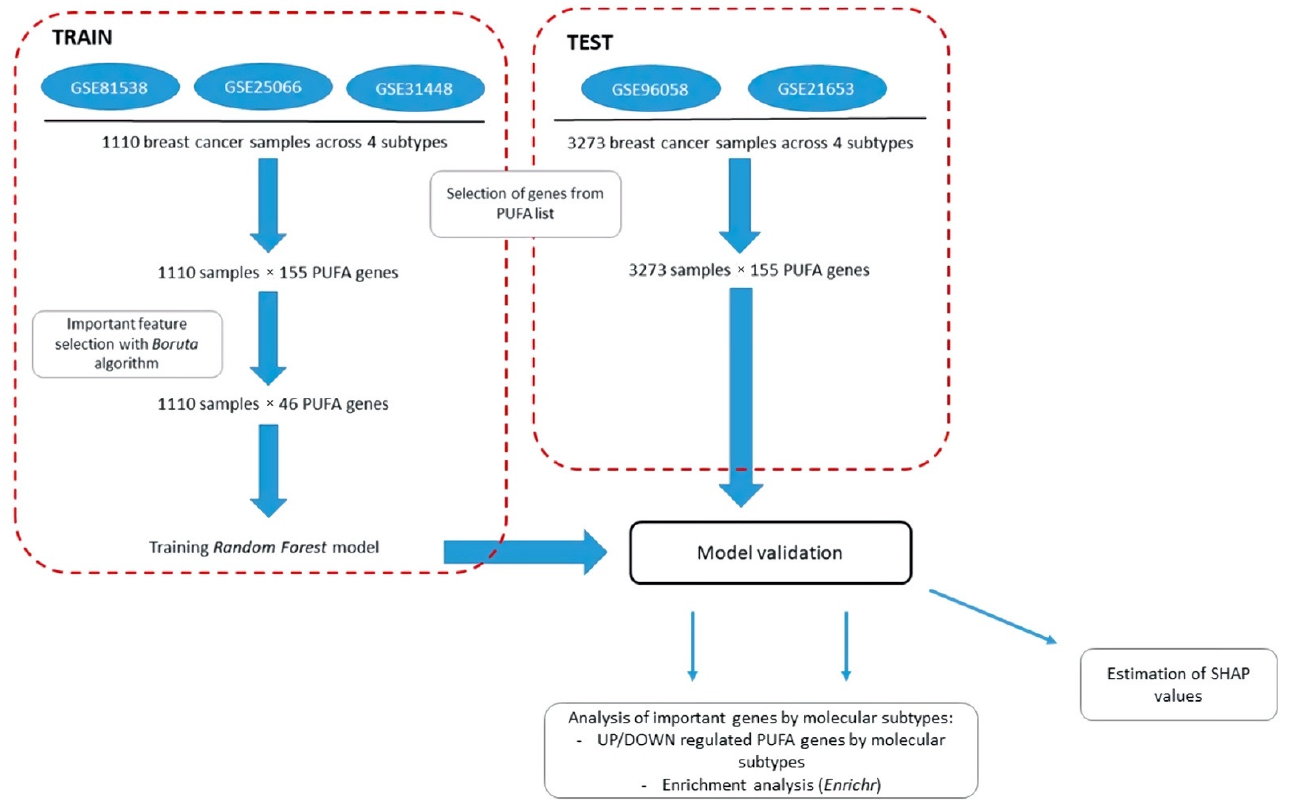
Figure 4. Workflow for studying differences in PUFA metabolism across four molecular subtypes of breast cancer. Processed expression matrixes for GSE81538, GSE25066, GSE31448, GSE21653, and GSE96058 datasets are collected from GEO database. Gene expression levels are ranked, and PUFA genes (155 genes) selected in training and test sets. Final model is built on the list of 46 important PUFA genes extracted by Boruta selection algorithm. (See details in the Section 2).